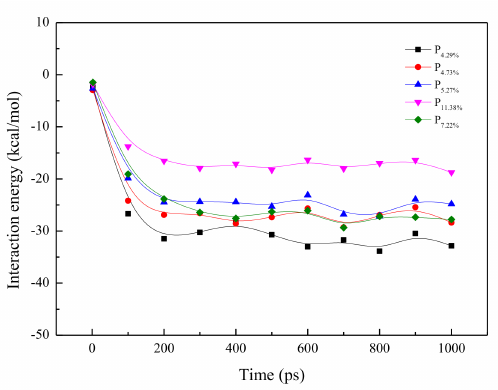
Figure 6. The interaction relationship between N 2 and H 2 O with the increase in